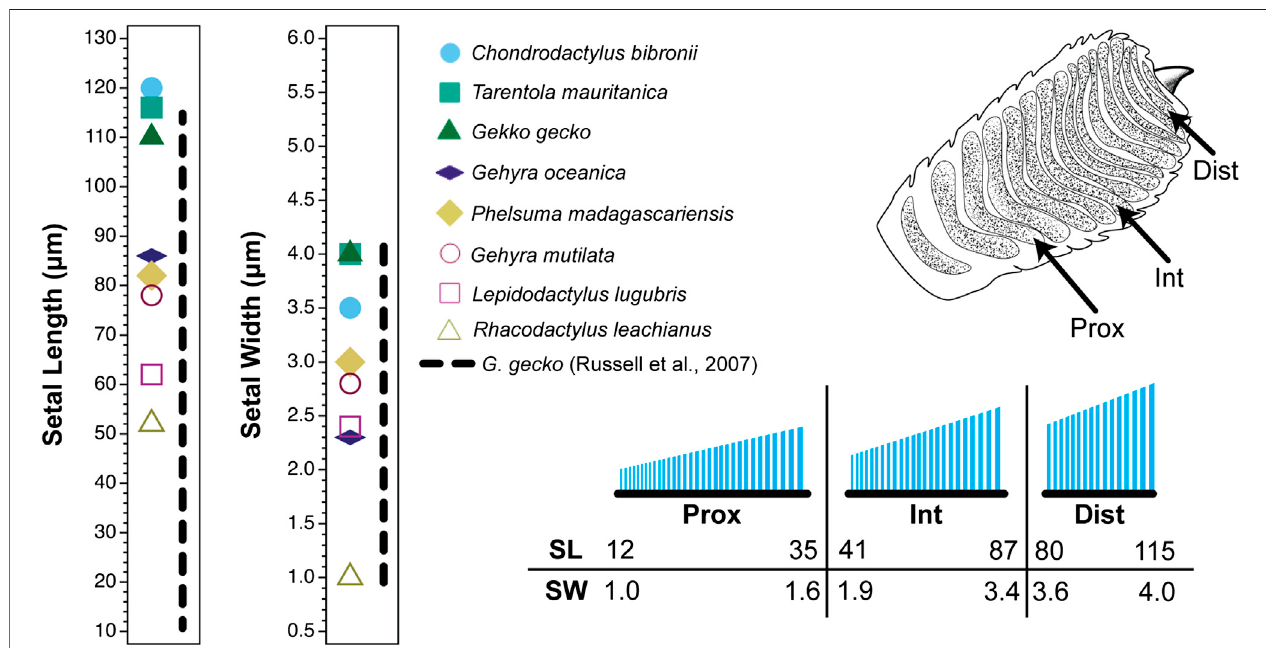
FIGURE2| SetaldimensionsrecordedfordigitIV,rightmanusofthegekkonidgecko Gekkogecko showingvariationinrelationtolocationonthetoepad.Dataare presented for a proximal (prox), intermediate (int) and distal (dist) scansor (see inset of the ventral view of the digit in the upper right corner of the fi gure). The different symbols on each graph at the left indicate singular values reported for setal length and width for eight gecko species by Peattie (2007) (see legend). The vertical dashed linetotherightofthesymbolsforeachgraphrepresentstherangeofvaluesexpressedby Gekkogecko asmeasuredbyRusselletal.(2007).Thelowerrightinsetis a schematic ofthe setae on theproximal, intermediate and distal scansors. Below this schematic are values ofparticular setallengths(SL; µm) and widths (SW;µm) that correspond to proximal and distal stations along the proximodistal length of each scansor (distal to the right).